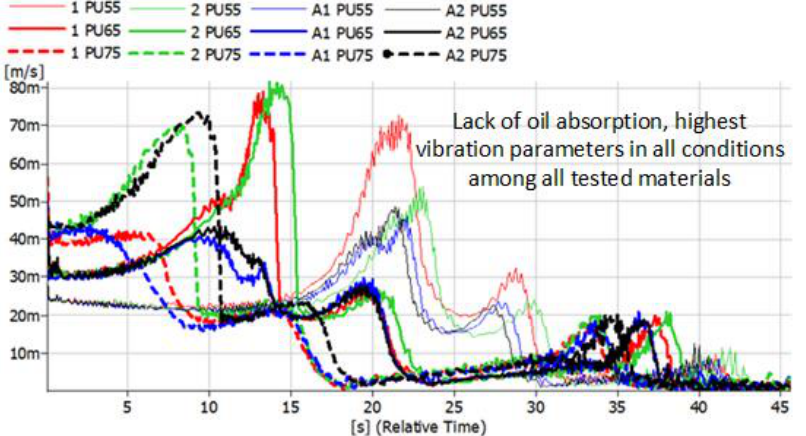
Figure 15. Vibration parameters during the run-down process with PU absorbers installed in the vibration insulation system.